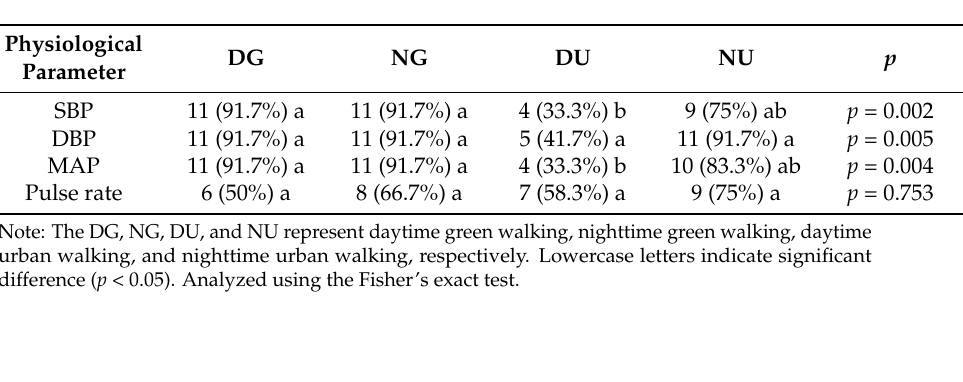
Figure 10. The physiological changes of walking in different scenarios. The ( a ), ( b ), ( c ), and ( d ) represent changes in SBP, DBP, MAP, and pulse rate respectively. The DG, NG, DU, and NU represent daytime green walking, nighttime Table 7. Proportions of participants with positive responses in measured parameters after walking in green walking, daytime urban walking, and nighttime urban walking, respectively. The error bar represents standard different error, * represents p < 0.05, and ** represents p < 0.01. Analyzed using the Kruskal–Wallis test ( N = 12).